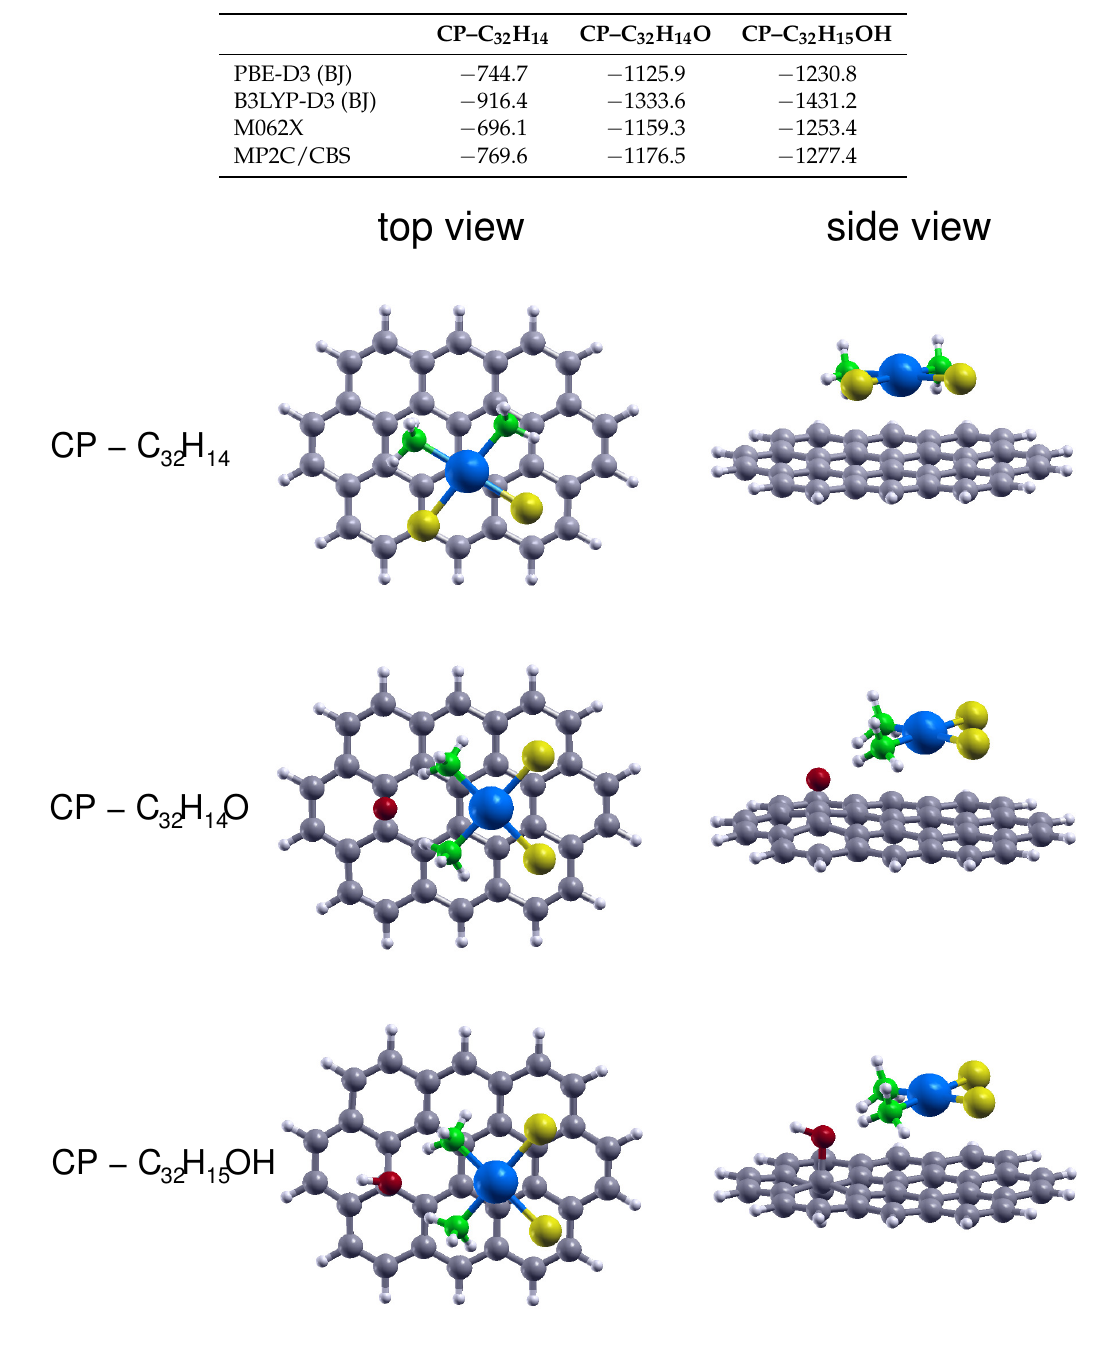
Figure 2. Top and side views of the CP–C 32 H 14 , CP–C 32 H 14 O and CP–C 32 H 15 OH complexes whose structures have been optimized by means of DFT computations at the PBE-D3 (BJ) level. The corresponding interaction energies are reported in Table